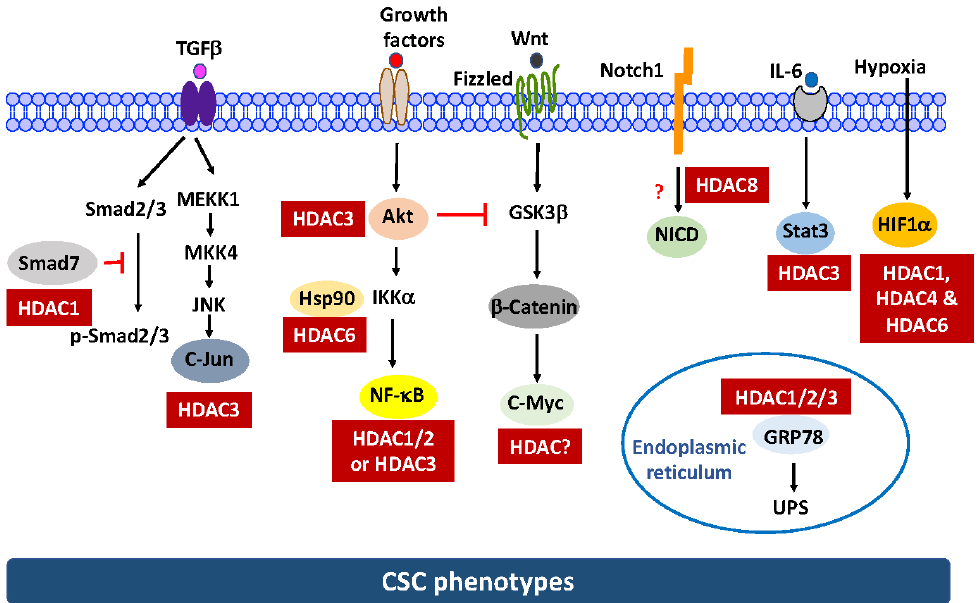
Figure 2. Role of histone deacetylase (HDAC) isoforms in regulating signaling effectors pertinent to CSC maintenance. The mechanism by which HDAC8 regulates the stability of Notch1 and the identity of the HDAC isoform responsible for c-Myc deacetylation remain undefined and are thus represented by dashed lines. The red question marks and red T-bar arrows denote unknown mechanism/isoform identity and negative regulation, respectively.